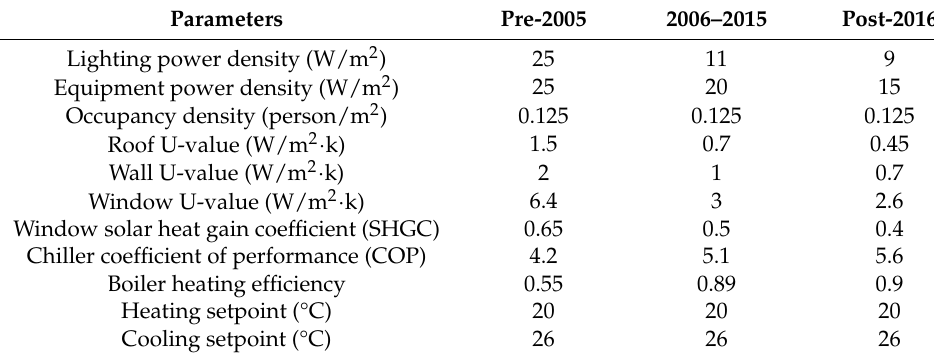
Table 8. The input parameters used in office space.